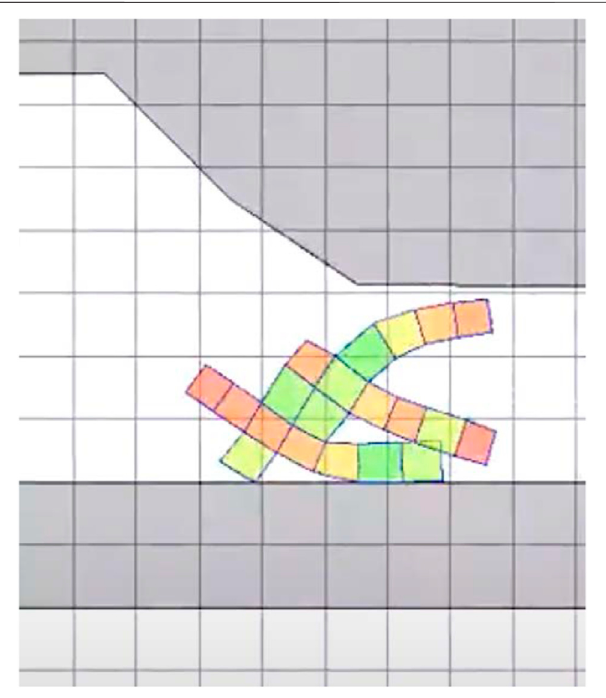
FIGURE 6 | Example of cave-like environment used in the escape